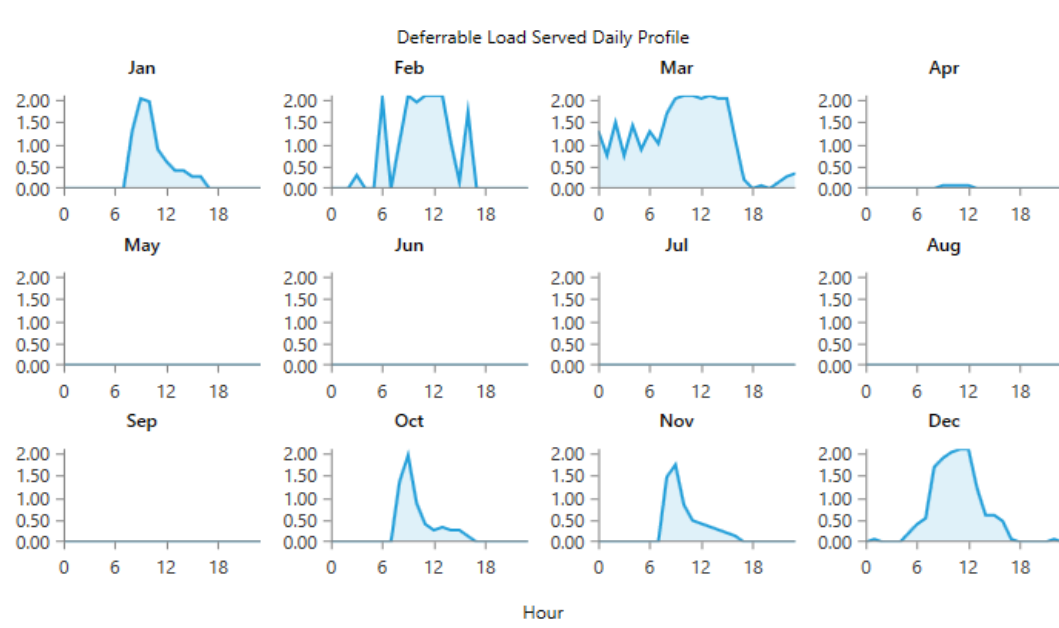
Figure 13. Power generation share at Site 10 (PV represents solar PV generation, and G1 represents wind turbine generation).